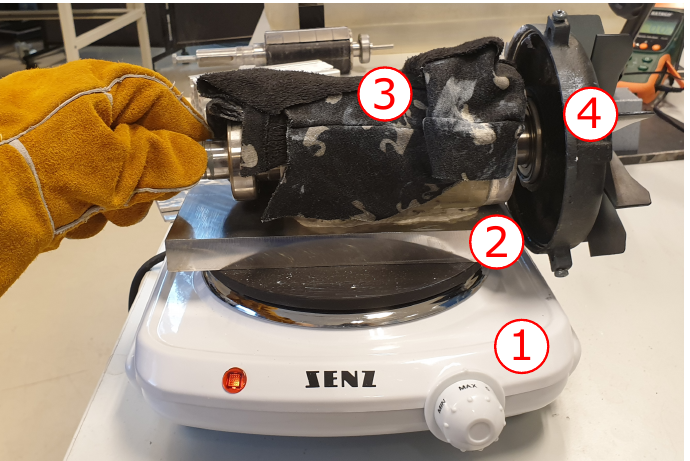
Figure 4. Thermal treatment setup consisting of (1) cooking plate, (2) solid aluminium block, (3) wet towel, and (4) the rotor.